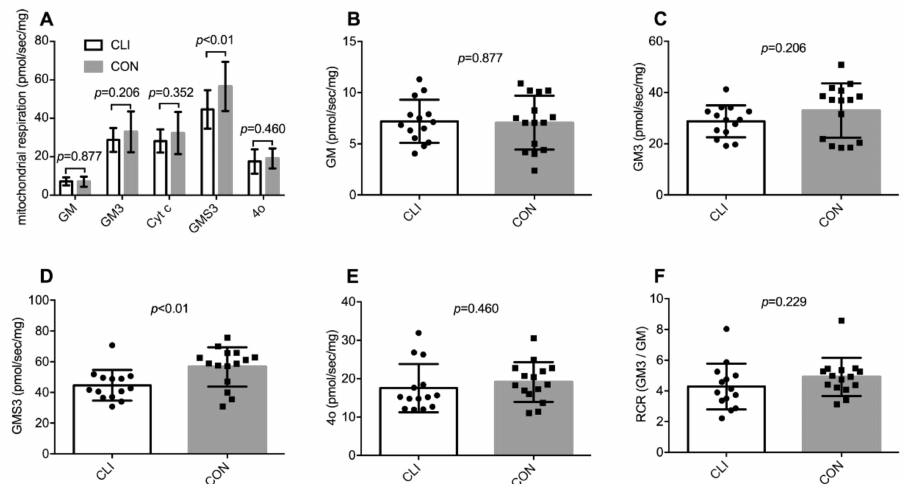
Figure 3. Mitochondrial respiration per mg muscle tissue for CLI (n = 14) and CON (n = 15) patients. ( A ) Summary of all respiratory states after addition of: glutamate and malate (GM), ADP (GM3), cytochrome c (cyt c), succinate (GMS3), and oligomycin (4o). ( B – F ) Individual values for all respiratory states and the respiratory control ratio (RCR) with complex I-linked substrates. Data are presented as means ±